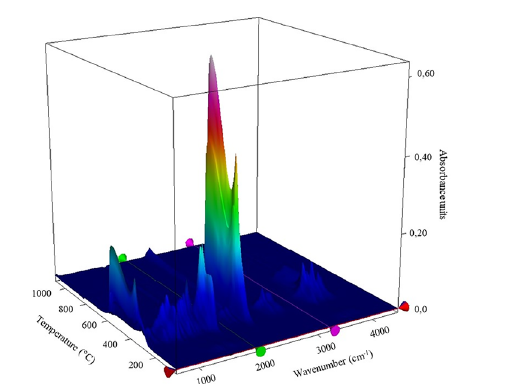
Figure 8. Infrared spectrum of gases resulting from the thermal analysis of jute